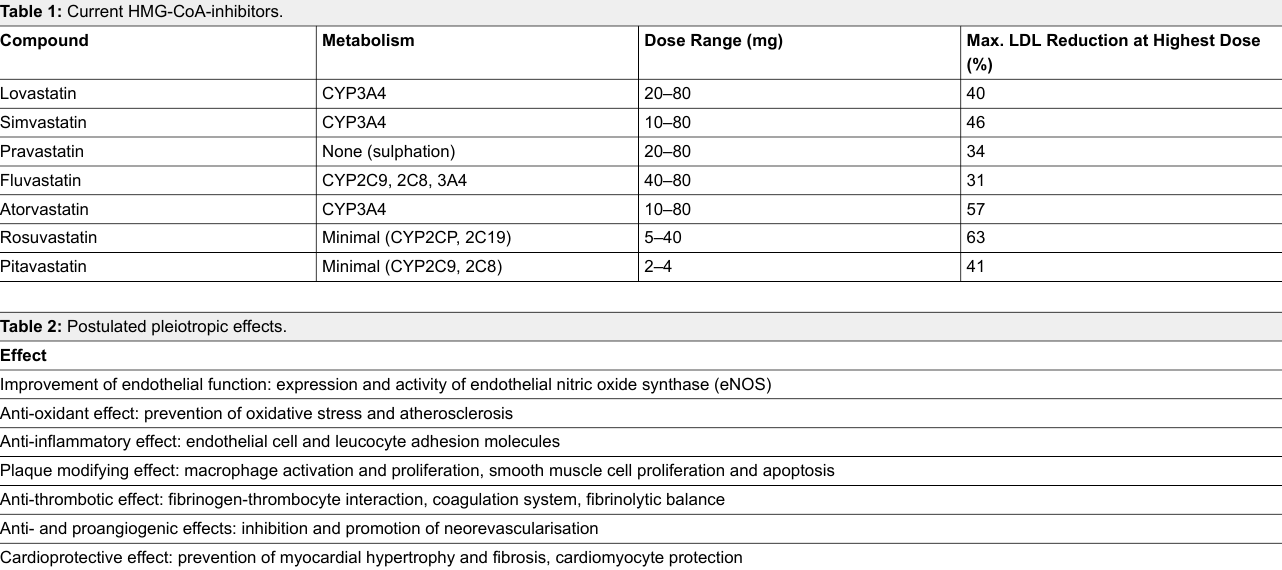
Table 2: Postulated pleiotropic effects.